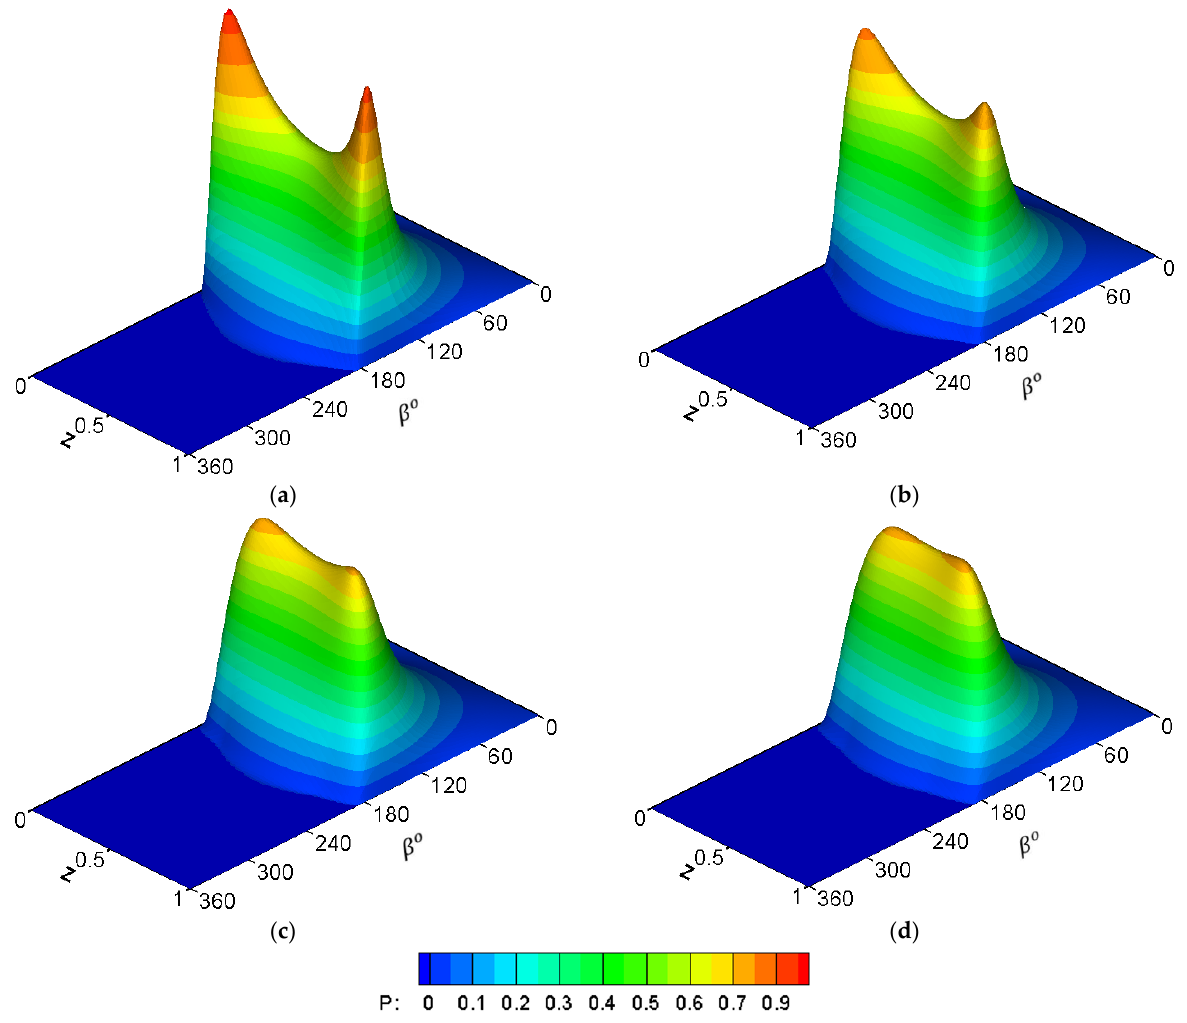
Figure 6. Effect of linear modification on dimensionless pressure distribution ( L / D = 1.25) when ∆ℎ (cid:3042) = ∆𝑣 (cid:3042) = 0.58 ( a ): Without modification, ( b ): 𝐴 = 𝐵 = 0.1 , ( c ): 𝐴 = 𝐵 = 0.2 and ( d ): 𝐴 = 𝐵 = 0.25 .